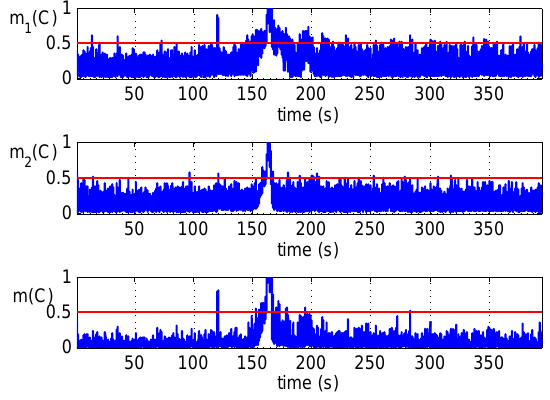
Figure 9. Detections’ fusion of the Scenario 3 dataset.